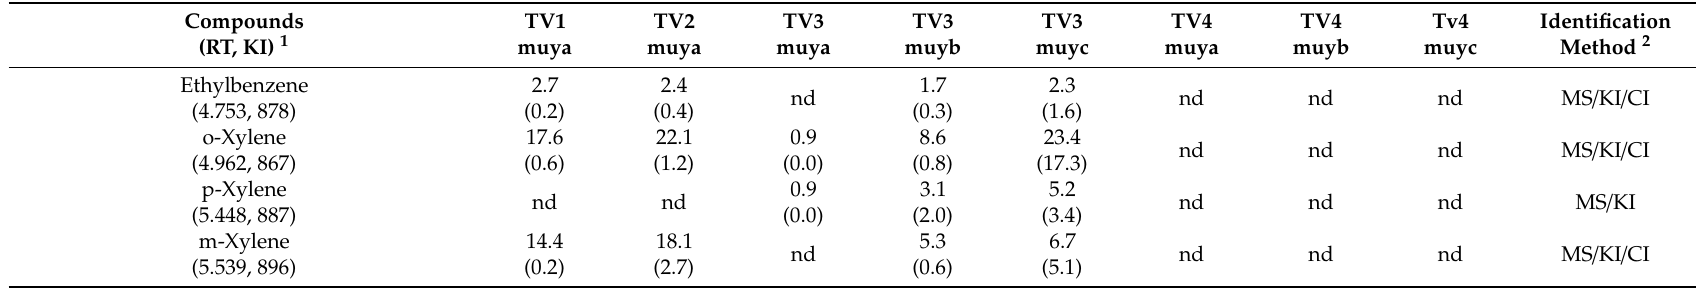
Table 3. Mean peak area (% ± SEM) composition of major chemical constituents identified in the essential oils of T. vogelii samples from Muyago